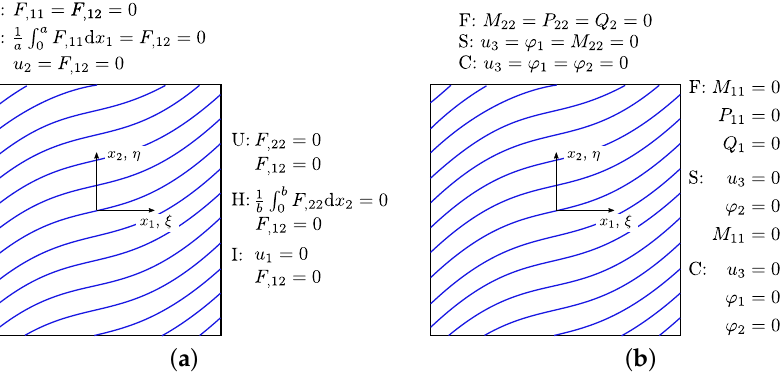
Figure 2. Comparison between different methods: ( a ) in-plane conditions; ( b ) flexural